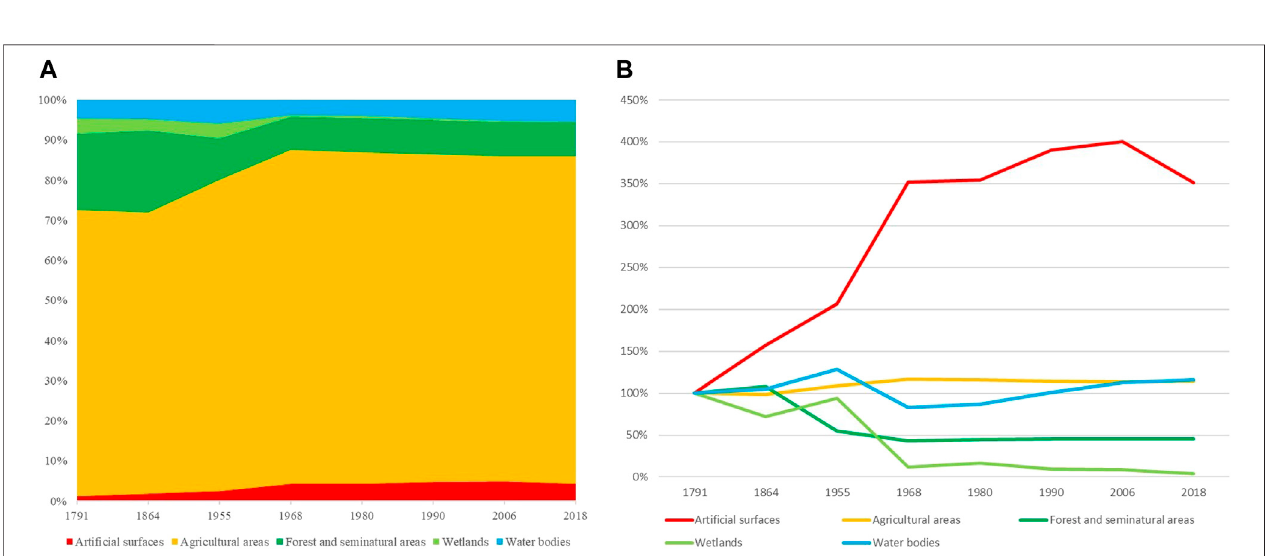
FIGURE 6 | Landscape changes in study area from Mosti ș tea Basin (1791 – 2018). (A) Percentage of increased areas compared to the total surface area. (B) Percentage of increased areas compared to 1791.